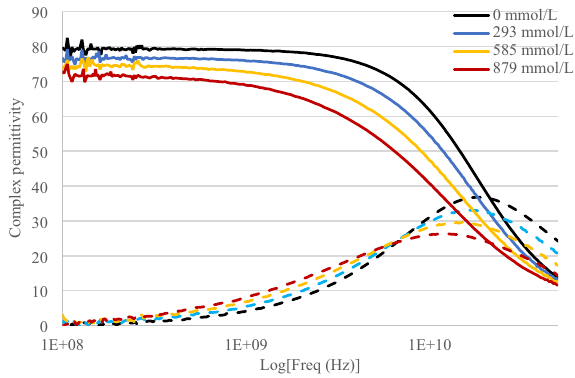
Figure 3. Complex permittivity (real part (line) and imaginary part (dash line)) as a function of frequency (logarithmic scale) for various sucrose